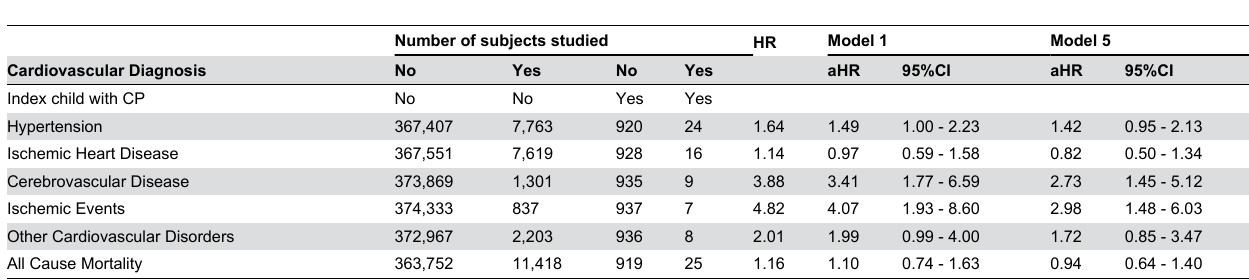
Table 4. Hazard ratio of specific cardiovascular disease diagnoses in mothers of a male CP